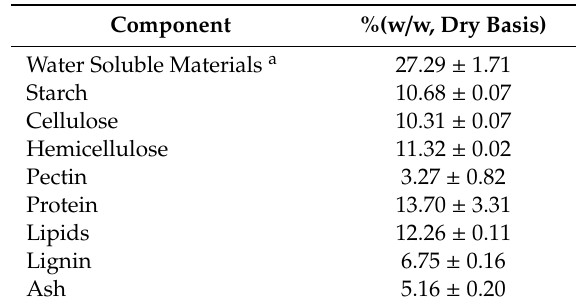
Table 1. Chemical analysis of dried